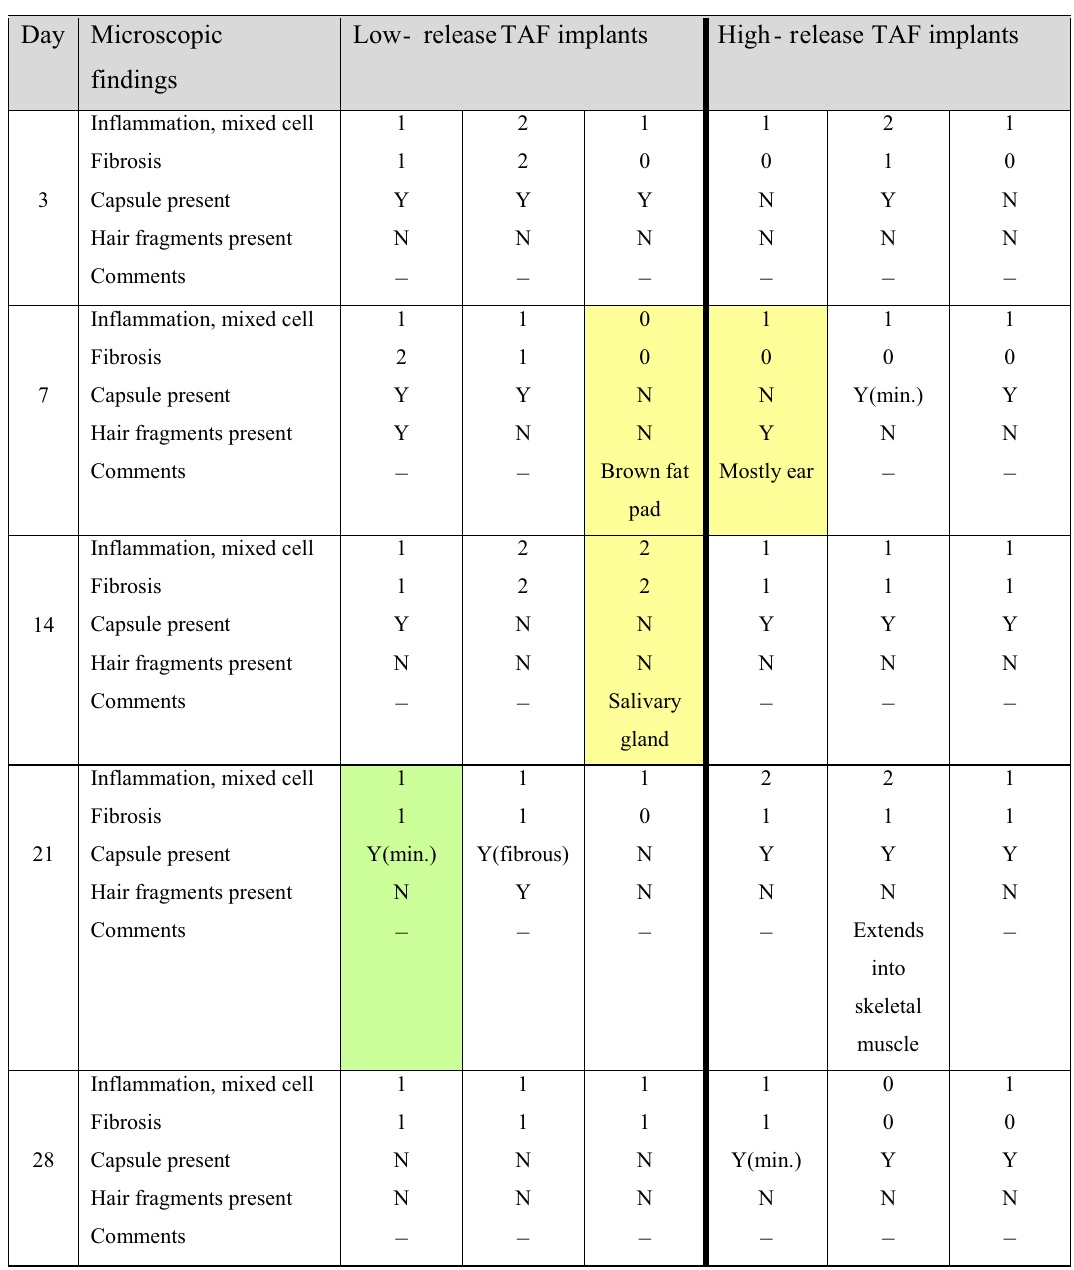
Table 3. Histopathology-scored report of H&E-stained tissue sections of dermal tissues collected during subdermal TAF implant studies. Definitions: Inflammation, mixed cell-inflammation with cellular infiltrates consisting of monocytes, macrophages (sometimes vacuolated), lymphocytes, and variable number of neutrophils. Cellular infiltrates were present in the white adipose tissue surrounding the capsule, within the outer capsule wall, and sometimes in the lumen of the capsule. Fibrosis, proliferation of fibroblasts (less mature, without much collagen) or increased mature fibroblasts and collagen; Capsule, thin strip of eosinophilic fibrillar material presumably surrounding implant; in one animal the capsule consisted of fibrous tissue (D21, “Low Release 1”, shaded green). Cells shaded yellow did not contain any capsule and consisted mostly of other tissues (e.g., brown fat, ear, salivary gland). The grading scale was between 1 and 5: 1, minimal; 2, mild; 3, moderate; 4, marked; 0, not